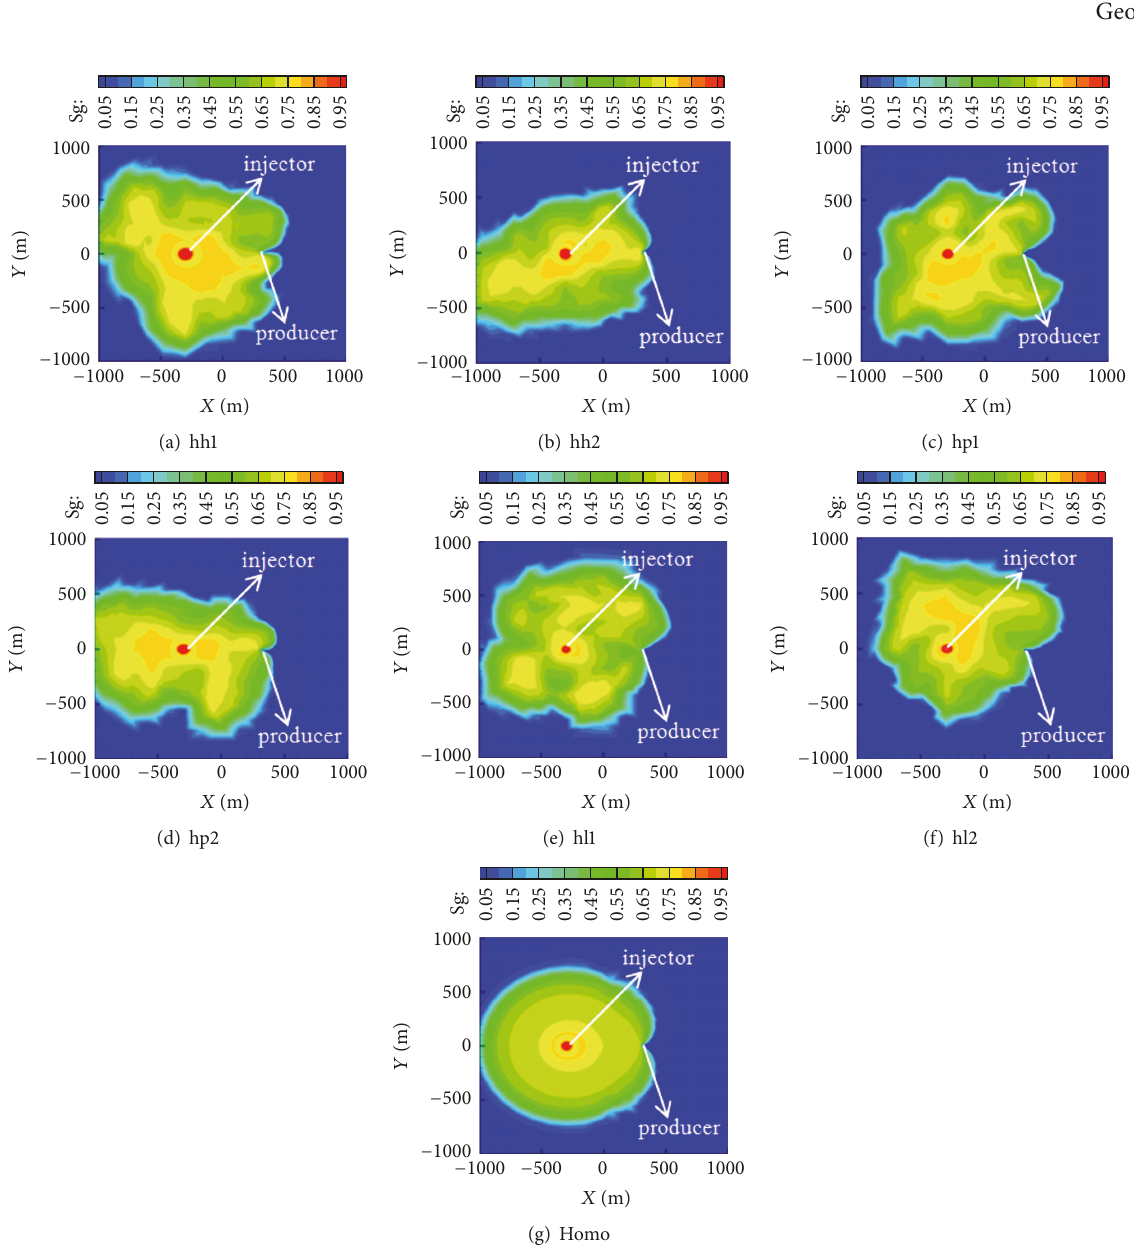
permeability zone between two wells. Correspondingly, in hl1 and hl2 cases, the breakthrough time is 1.4 years and 1.5 years, respectively, due to the low permeable belt between the injection and production wells. After CO 2 reached the production well, the saturation of CO 2 in the output fluids increased rapidly to over 0.9 (Figure 4(a)). The dive of curves in the figures is caused by the increasing of production pressure (from 0.1 MPa to 8 MPa as mentioned before). After that, the saturation of CO 2 recovered smoothly and stayed at about 0.92 during the rest operation